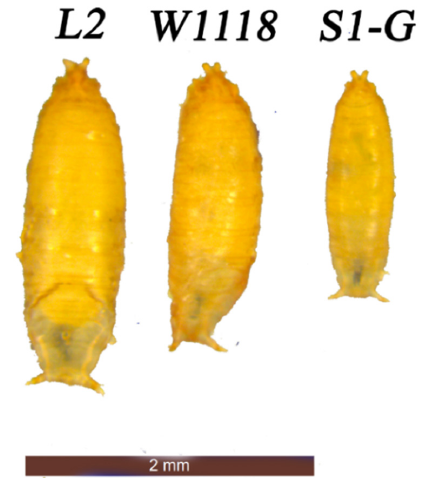
Figure 2. Pupal cases for D. melanogaster selected for large and small body size. All strains from this picture were maintained together, fed from the same batch of medium and the vials established for this image were started on the same day.